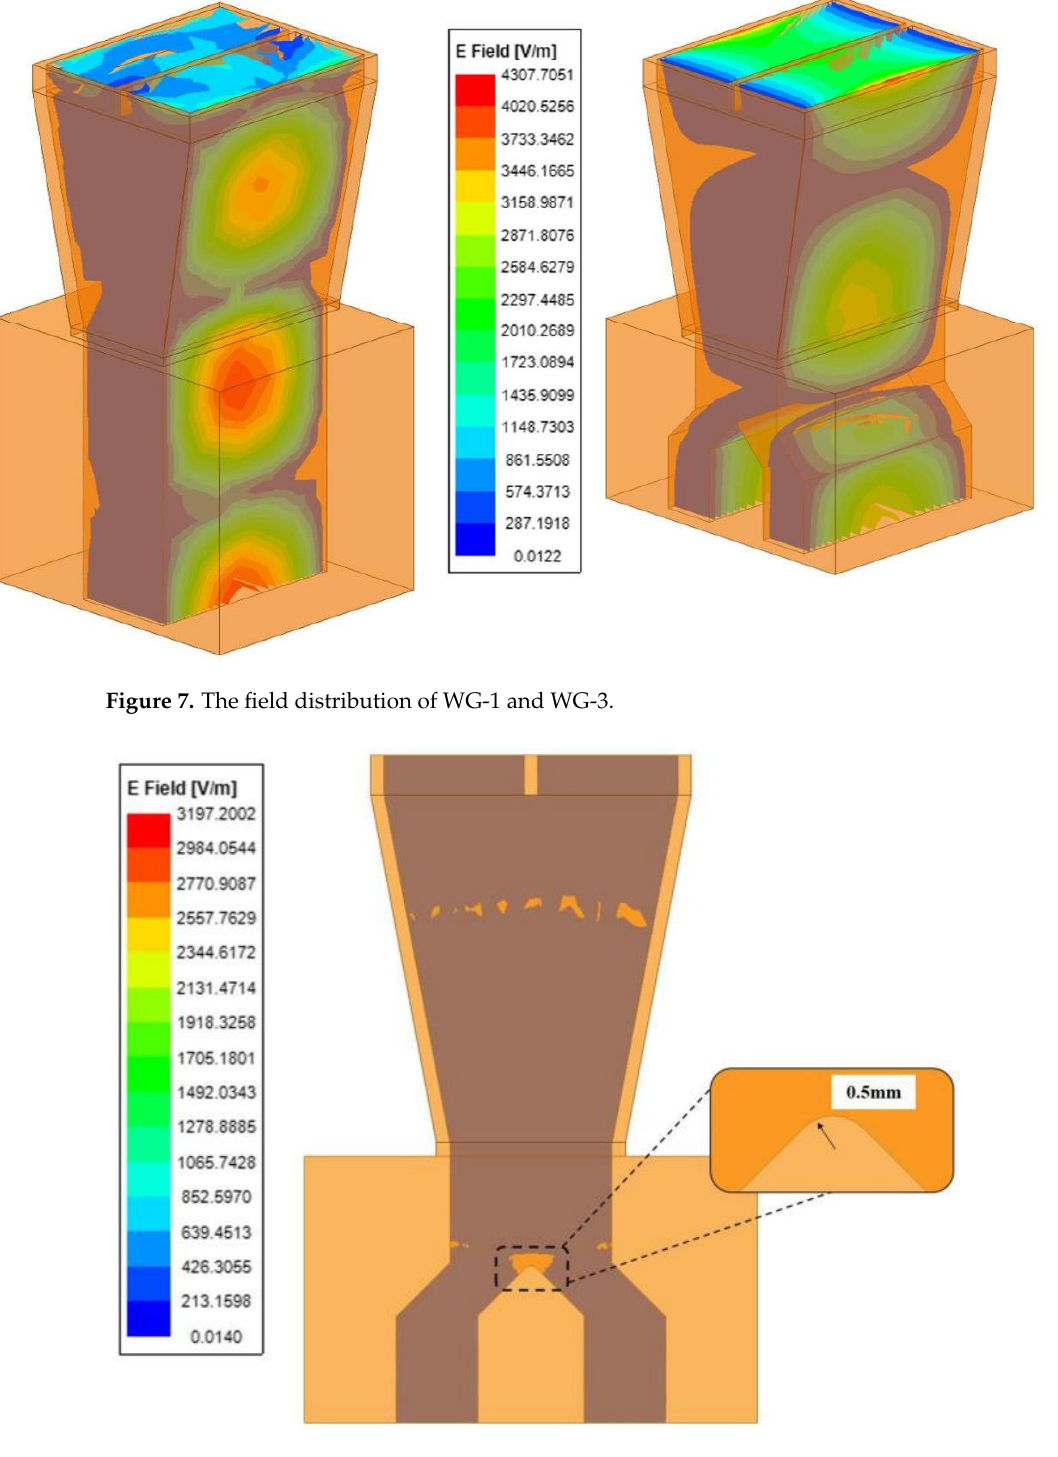
Figure 8. The field distribution of the HPM antenna unit.